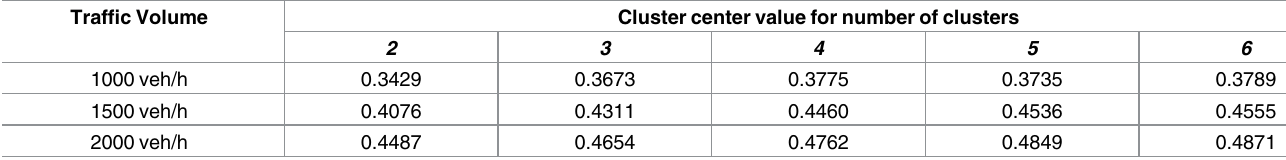
Table 3. Largest cluster center with different cluster number.